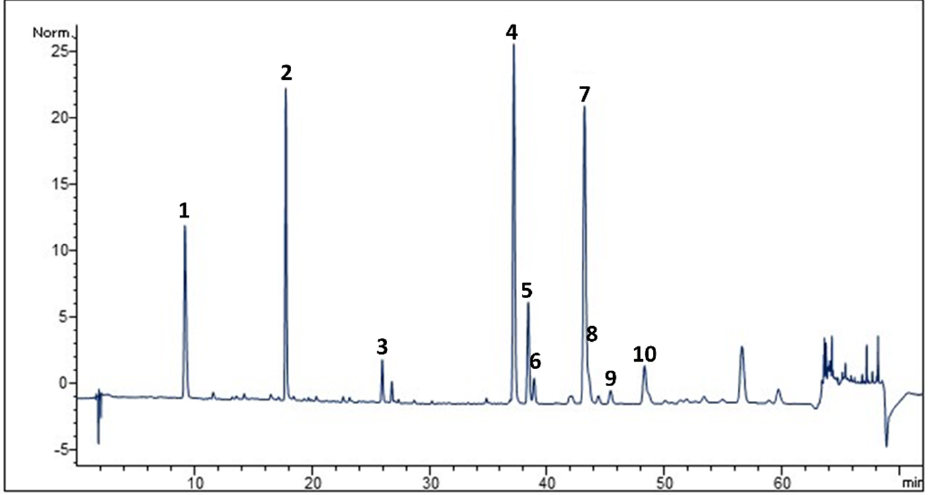
Figure 1. HPLC-DAD polyphenol fingerprint of Cynara sylvestris leaf extract. Column: Ascentis Express C18, 15 cm × 4.6 mm, 2.7 µ m d.p. For peak identification, see Table 2. Table 2. Compounds in Cynara sylvestris leaf extract identified via HPLC-DAD. Peak